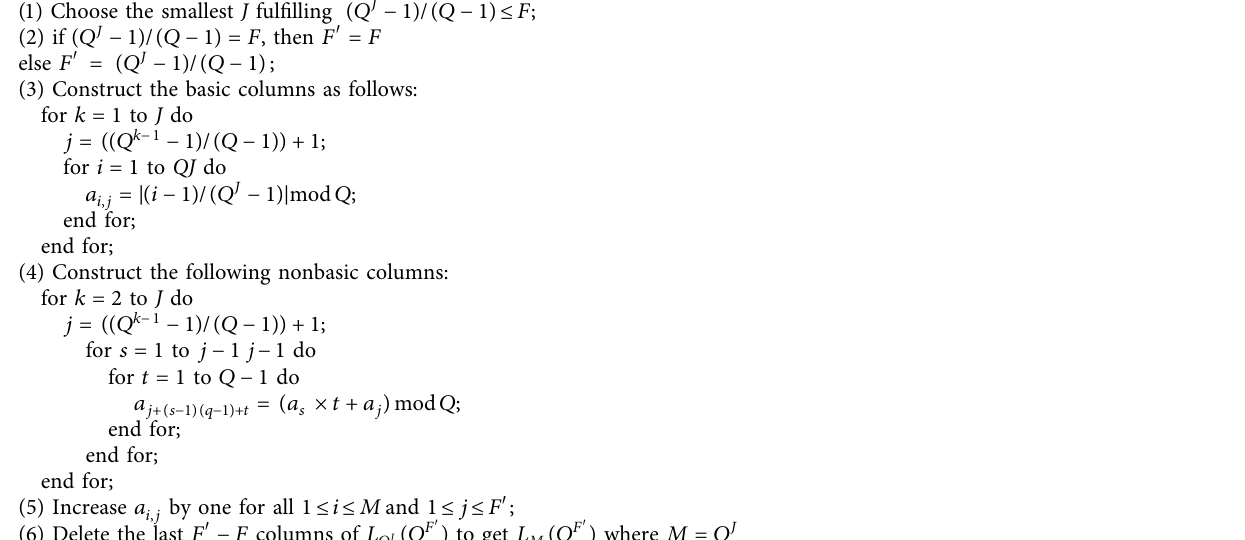
Table 2: The pseudocode of construction of the orthogonal table L